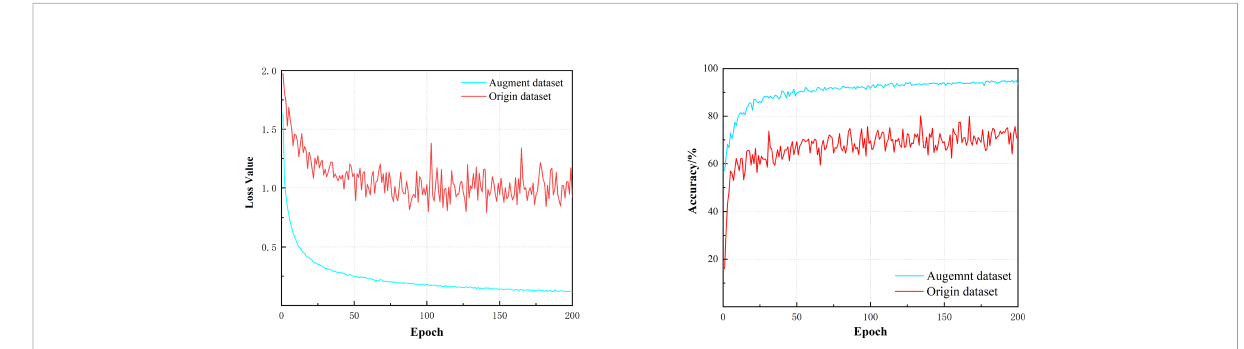
FIGURE 9 Loss Value and Accuracy changes of S-ResNet34 on the datasets before and after